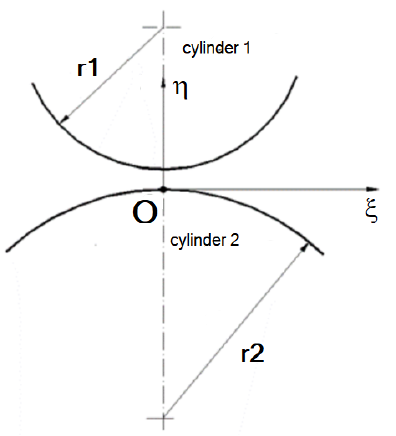
Figure 2. Scheme of the tooth pair